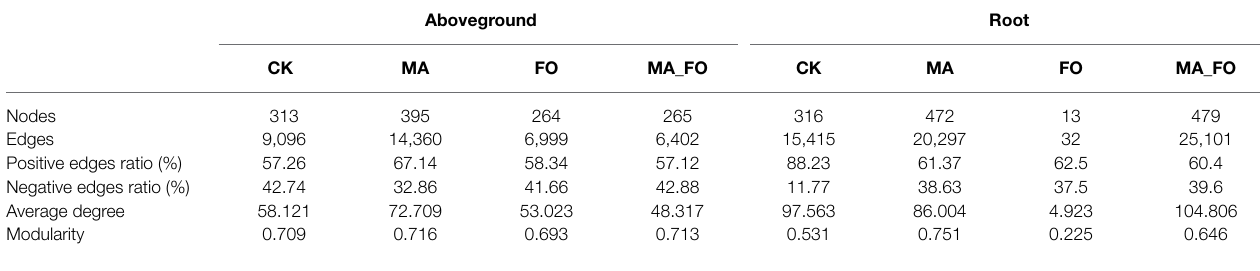
TABLE 3 | Key topological features of bacterial networks in aboveground and root of ginseng under different inoculation treatments. Aboveground